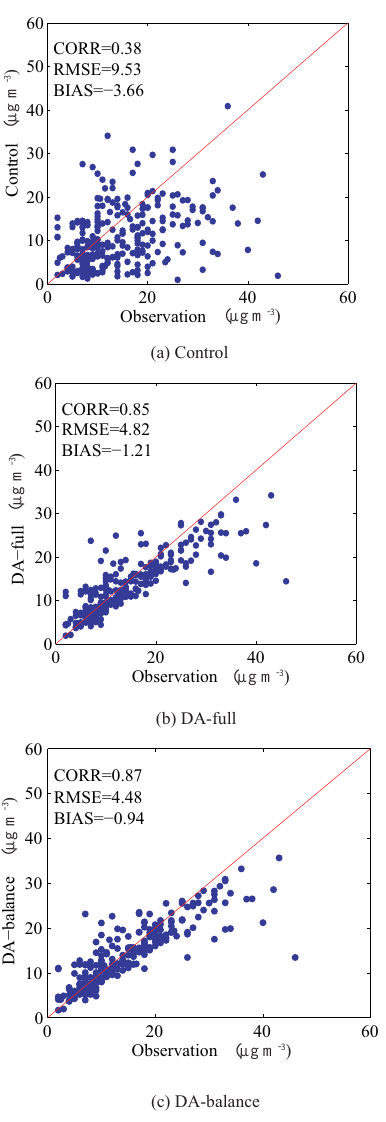
Figure 11. Scatter plots of observed concentrations of PM 2 . 5 vs. simulated PM 2 . 5 concentrations of the experiments of (a) Control, (b) DA-full, and (c) DA-balance for all nine cases.